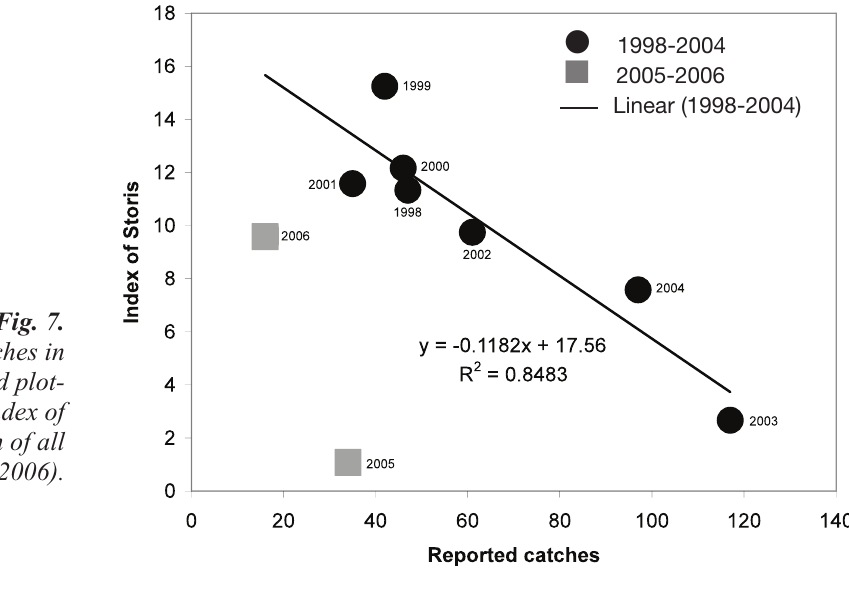
Harbour seal catches in South Greenland plot- ted against an index of “Storis” (mean of all months)